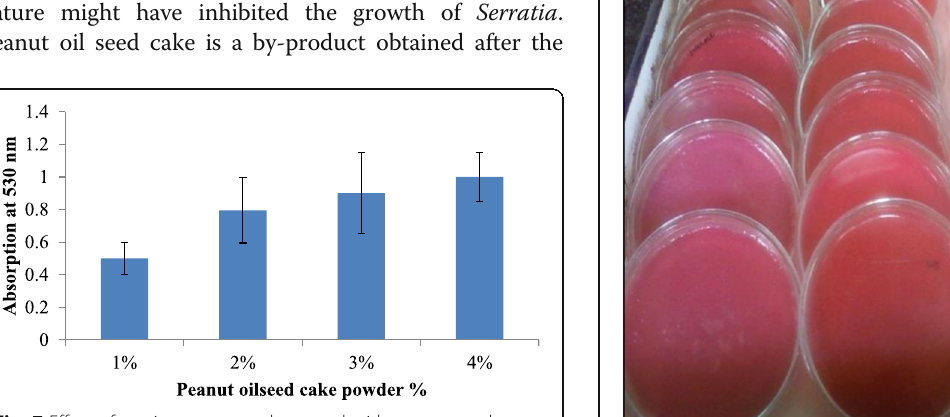
Fig. 7 Effect of nutrient agar supplemented with peanut seed